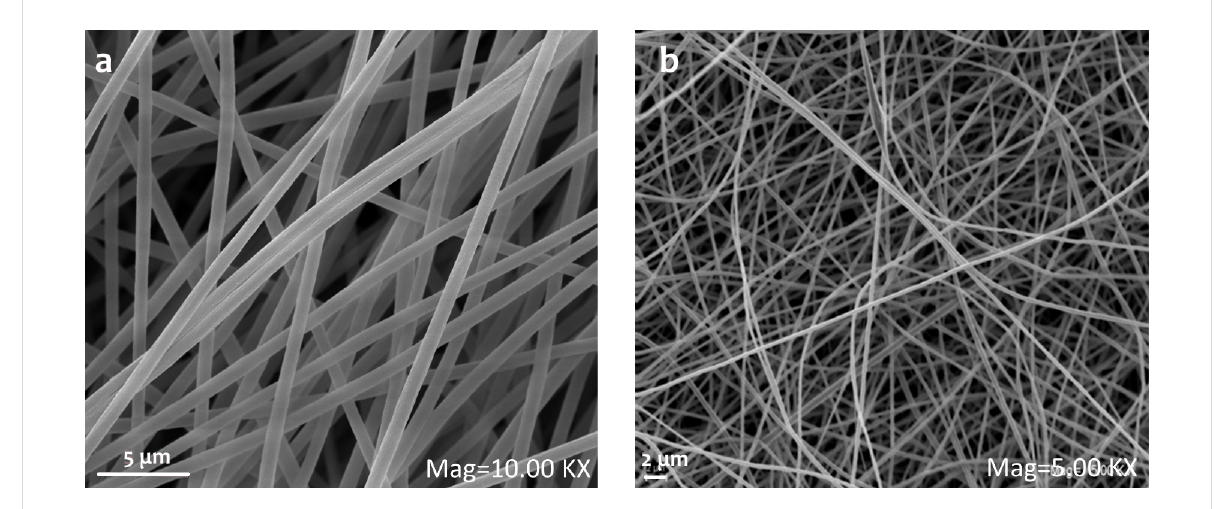
Figure 1: a) Web of aligned PAN nanofibers produced with rotating collector and b) web of PAN nanofibers produced with fixed collector.